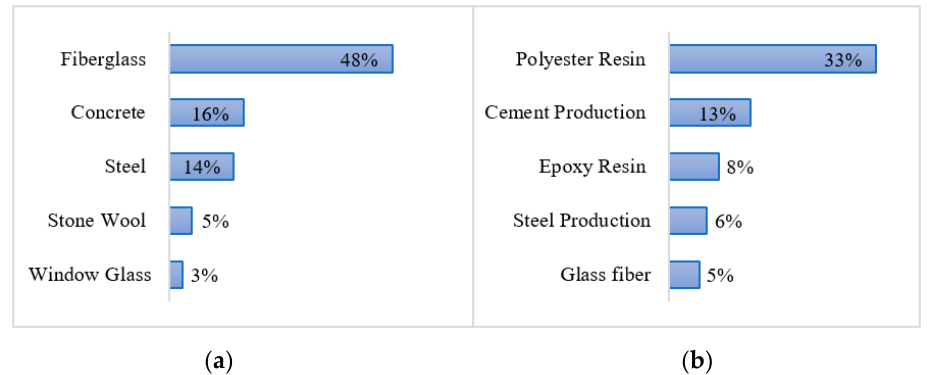
Figure 6. ( a ) Most contributing main materials to GWP. ( b ) Most contributing material sub-types to